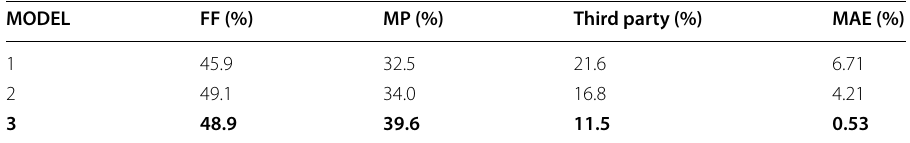
Table 6 Prediction results for the general election on October 27 of AI Models 1, 2, and 3 as defined in the